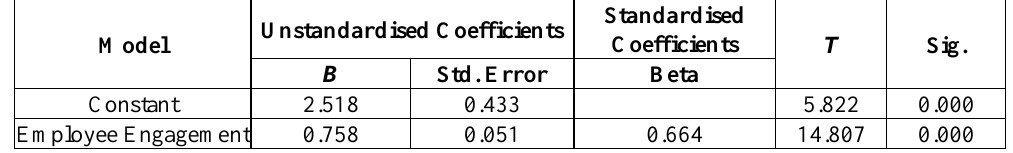
Table 3. Regression